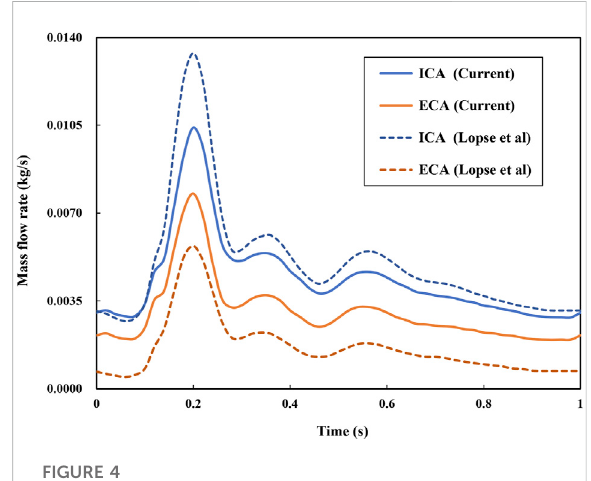
FIGURE 4 Comparison of simulated mass fl ow rates at two outlets with published data (Lopes et al.,